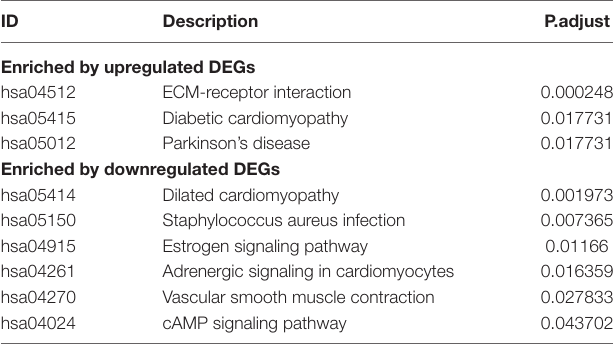
TABLE 1 | KEGG enrichment